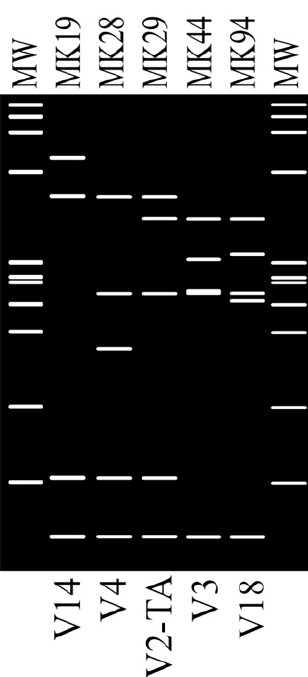
Figure 3. Virtual Rsa I profiles of representative bois noir phytoplasmas. Nucleotide sequences of phytoplasmas MK19, MK28, MK29, MK44, and MK94 (Table 1) were compiled in FASTA format, trimmed to TYPH10F/TY- PH10R fragments (approximately 1300-nt fragments), and Rsa I virtually digested. Virtual RFLP profiles were visu - alized on 3% agarose gel. FX174 digested by Hae III was selected as marker.